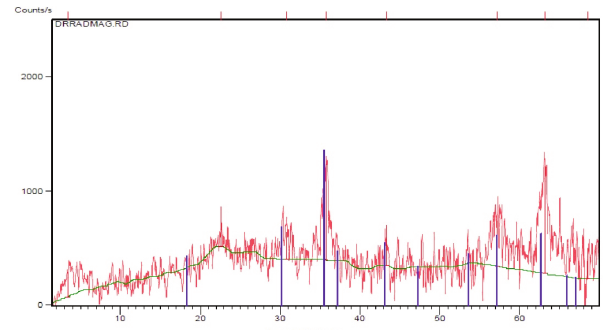
Fig. 4 - XRD pattern of magnetic nano-carboxymethylated chi- tosan. The widths of large peaks report crystal proper- ties of magnetic nanoparticles. The average of particles sizes based on Debye Scherrer equation was calculated 10